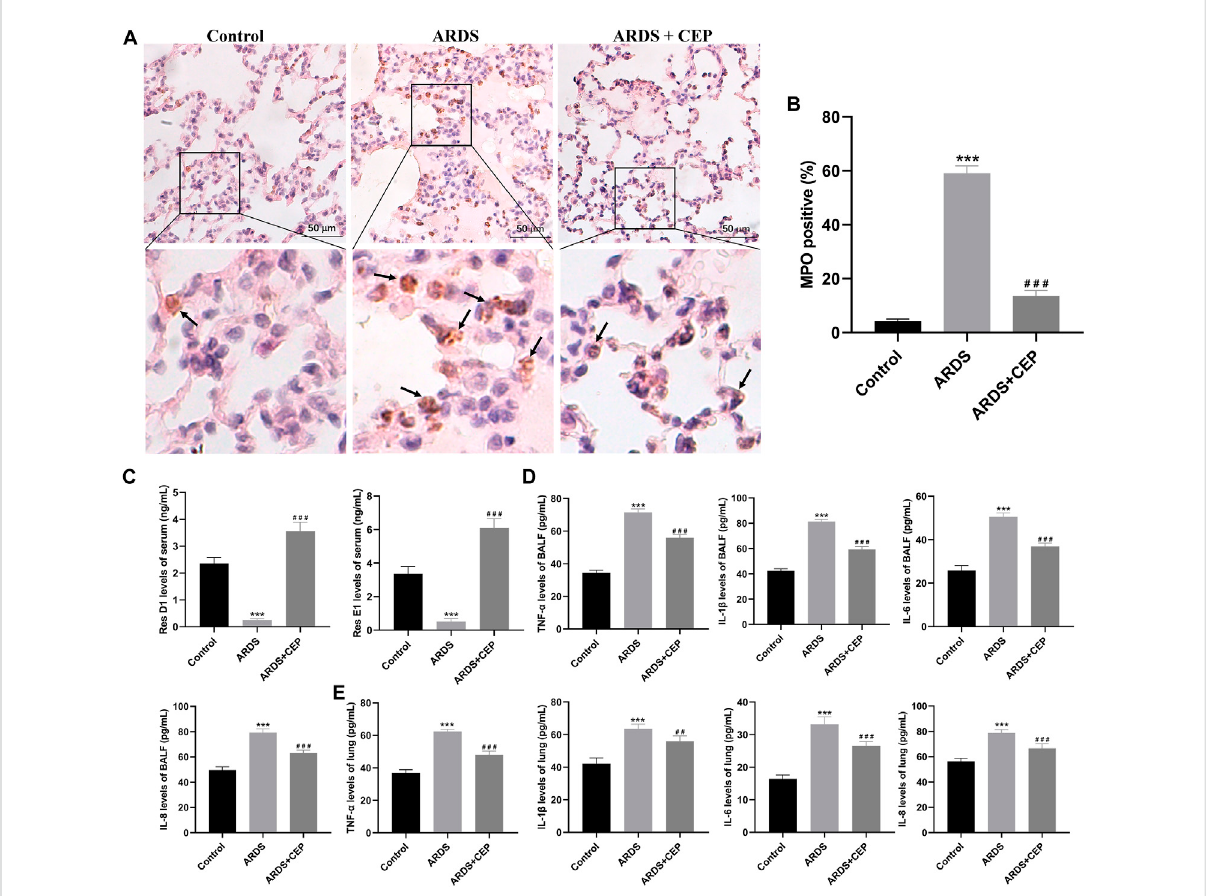
FIGURE 8 Effects of CEP on oleic acid induced-ARDS in fl ammation in rats. (A,B) Representative images of IHC staining for MPO (brown), a marker of neutrophilsandtheirquanti fi cationineachgroup.Scalebar=50 μ m. (C) LevelsofserumResD1andResE1assessedbyELISA. (D,E) LevelsofTNF- α , IL-1 β , IL-6, and IL-8 in BALF and lung tissues assessed by ELISA. Data are presented as the mean ± SD. *** p < 0.001, compared with the Control group; ## p < 0.01, ### p < 0.001, compared with the ARDS